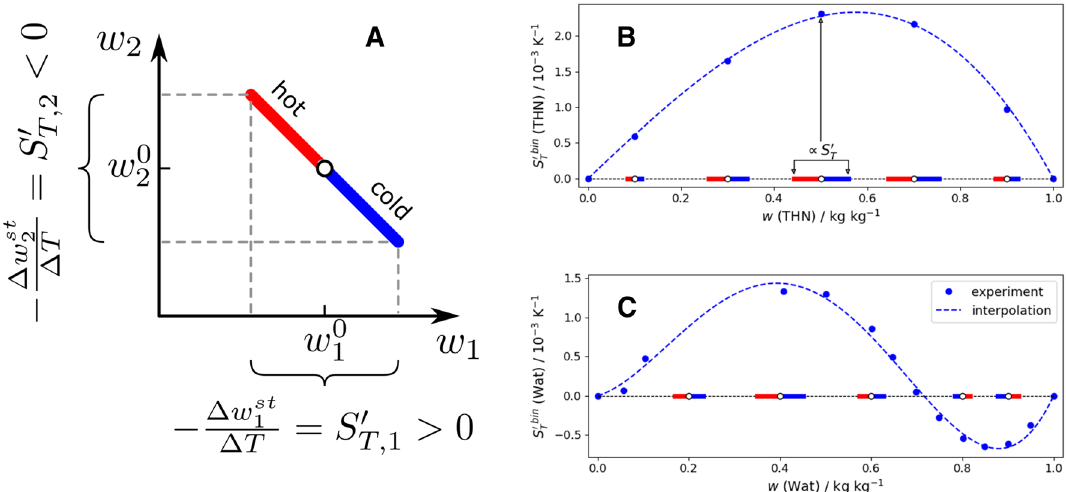
Figure 1. ( A ) Concept of the Soret vector in a ternary mixture. Presentation of the Soret vector over the composition range in binary systems ( B ) the THN–IBB mixture without the sign change of the Soret coefficient and ( C ) the Wat–EtOH mixture with a change in sign. The length of the vectors is shown to scale and is proportional to the value of the Soret coefficients. The Soret coefficients have been taken from literature, THN– IBB (Ref. 24 ) and Wat–EtOH (Ref. 25 ). The blue dots indicate experimental values while the dashed curves provide a visual